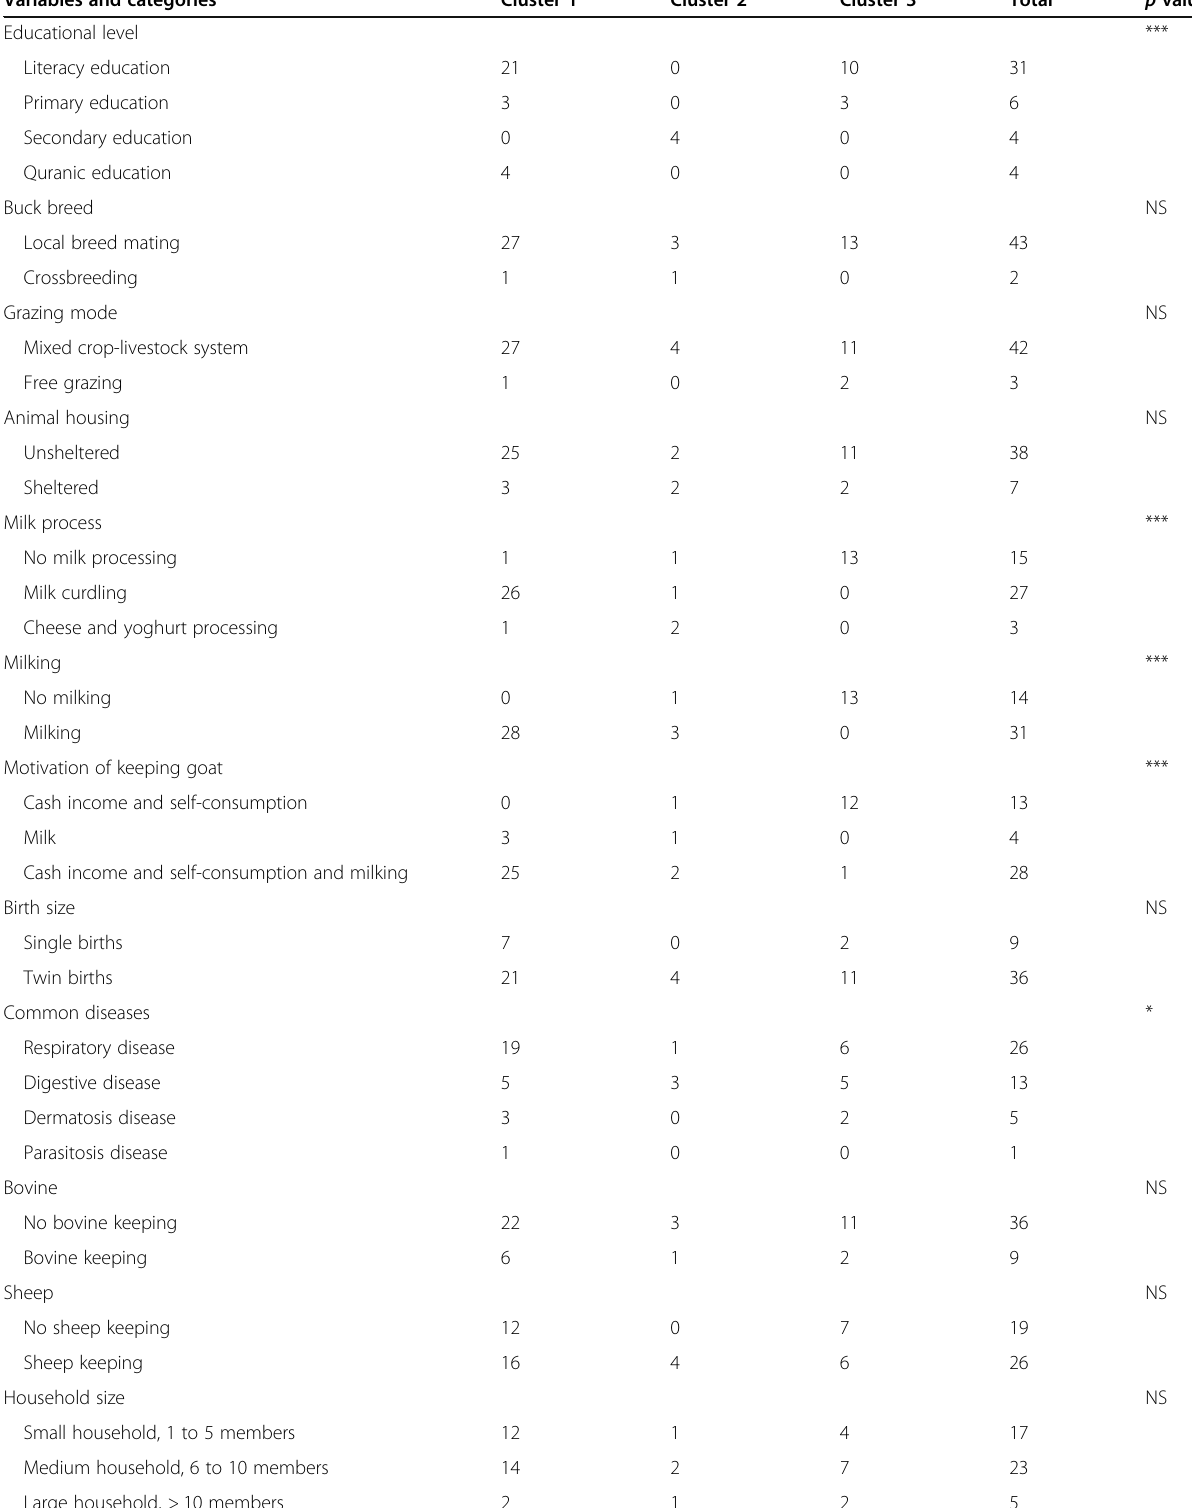
Table 2 Distribution of responders per categories for the three clusters identified by the hierarchical classification analysis Variables and